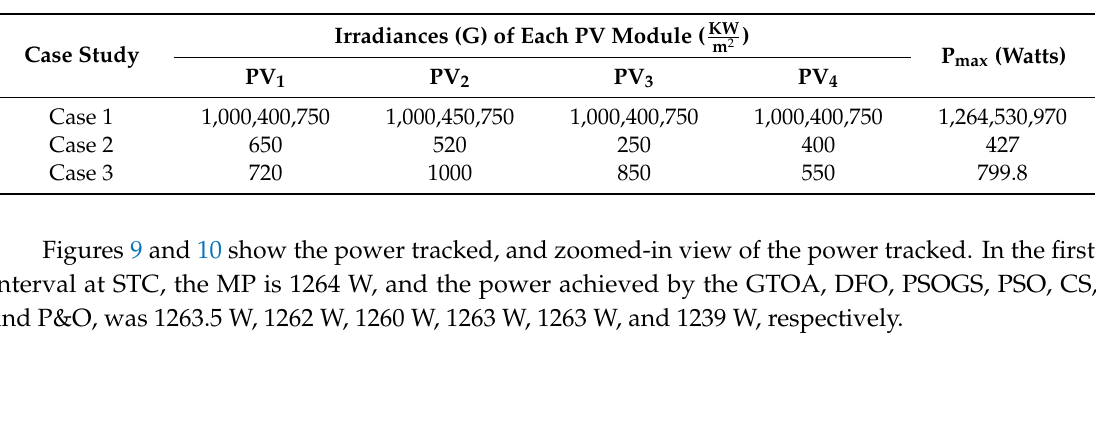
Table 2. Irradiance pattern PS